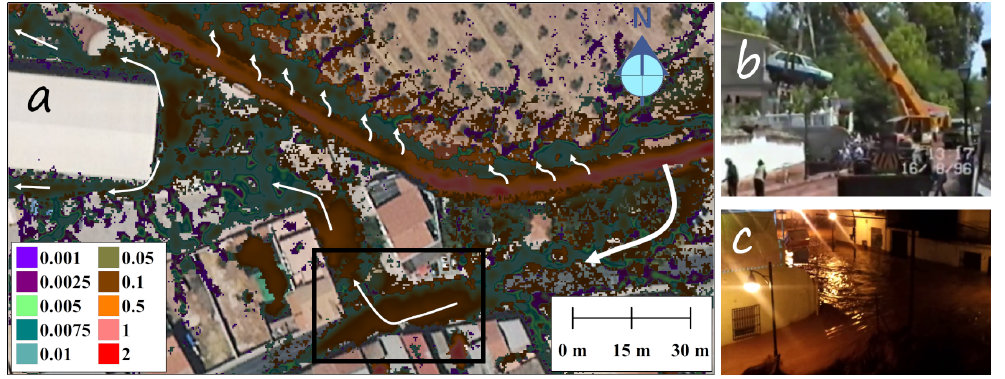
Figure 8. ( a ) Map of the simulated flow depth ( h in meter), for the present-day scenario CN89-A at the time of peak flow (i.e., t = 3 h), in the urban area inundated downstream of the overtopped artificial channel. Flow from right to left. The region in panel a occupies the blue rectangle in the flow-depth map shown in Figure 6a. The pictures on the right-hand side correspond to the inundations on ( b ) 15 August 1996 and ( c ) 8 March 2013 in the boxed area of panel a when the artificial channel was unable to protect the town from